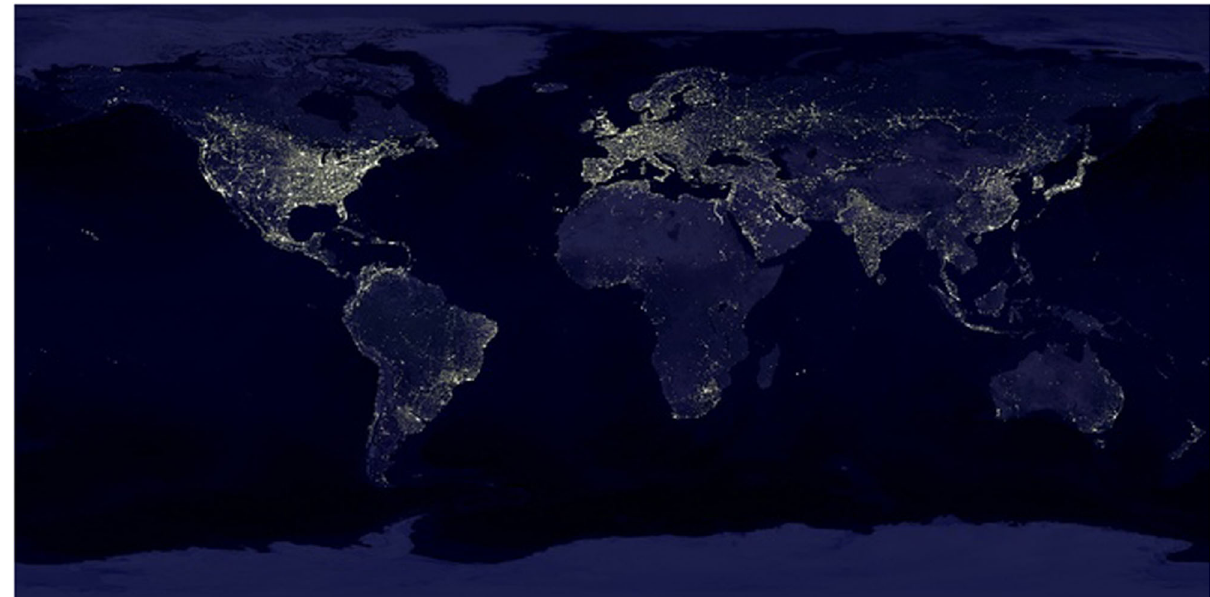
Fig. 5 Night Lights 2012 Map. Strava ’ s Global Heatmap reminds us of images of the Earth as seen from space. Even this “ God ’ s eye view ” of Earth, from NASA ’ s Earth at Night collection, is an example of situated data: it is a visualisation of fi ltered data gathered over a six month